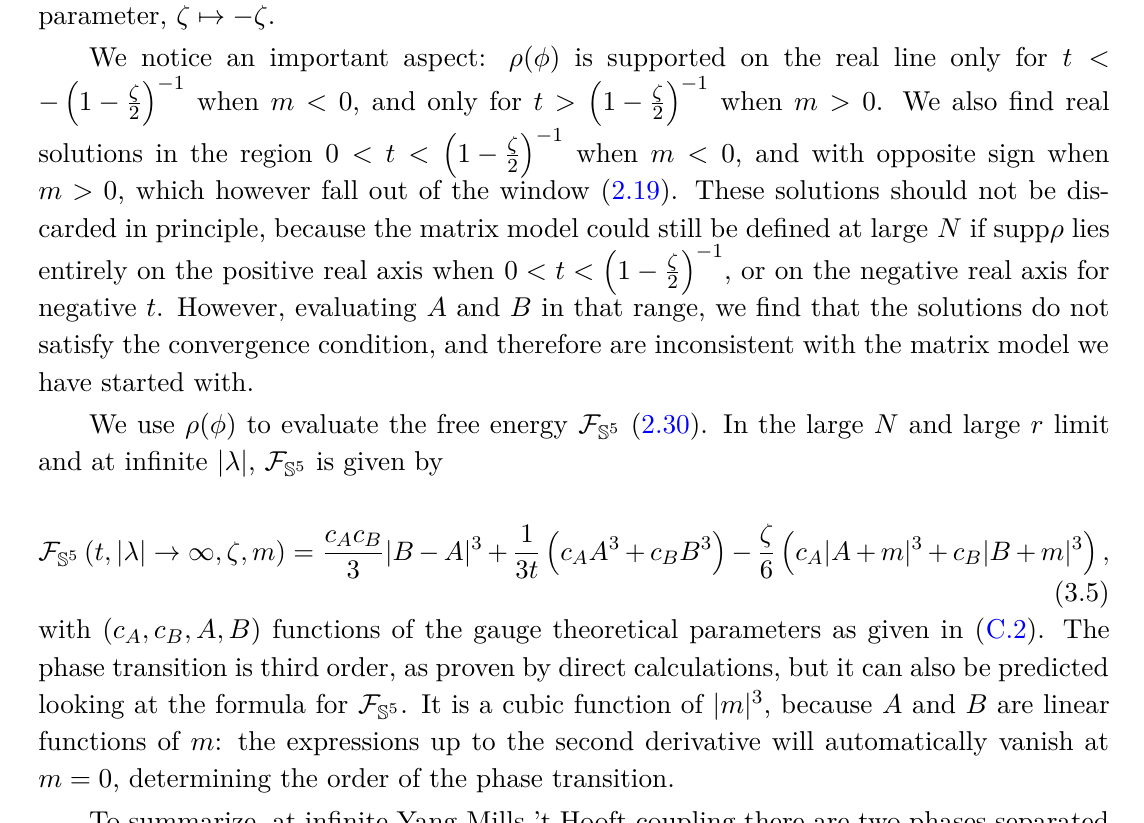
new phase, for which A > − m and hence sign ( φ + m ) > 0 . The solution is found exactly as before, and is also recovered from the ones at m < 0 flipping the sign of the Veneziano parameter, ζ 7→ − ζ